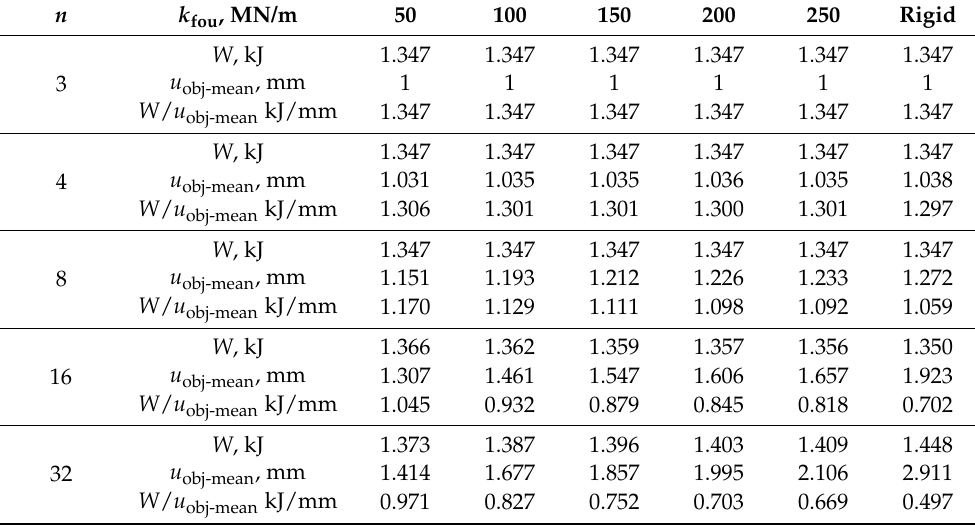
Table A14. Work done by the jacks during the forced piston extension in all the jacks by u ext = 1 mm and mean displacement of the object u obj-mean for n = 3, 4, 8, 16 and 32, k fou = 50, 100, 150, 200, 250 MN/m and k fou - rigid.